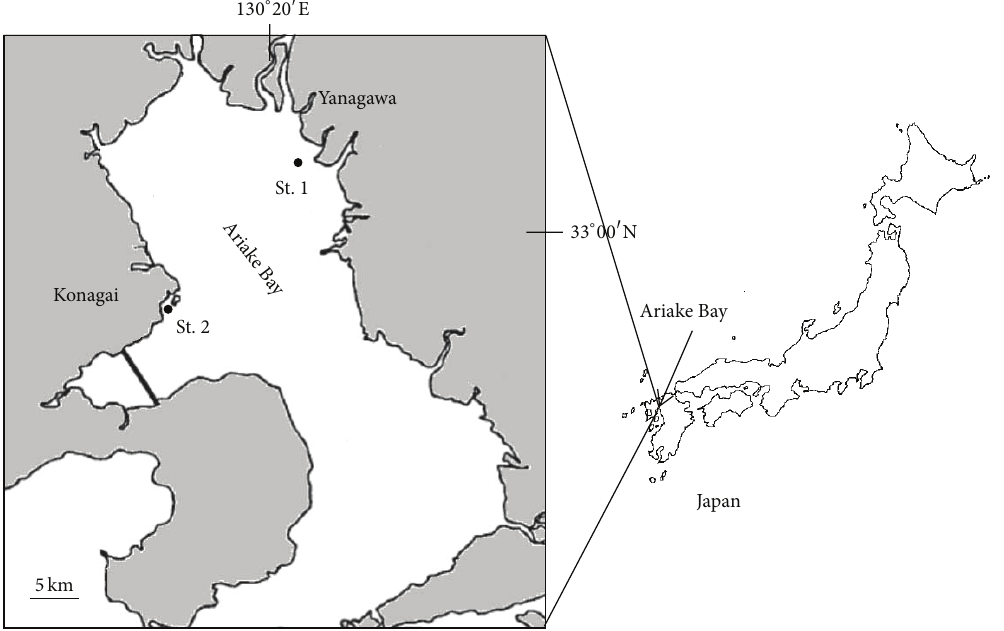
Figure 1: Sampling locations in Ariake Bay, West